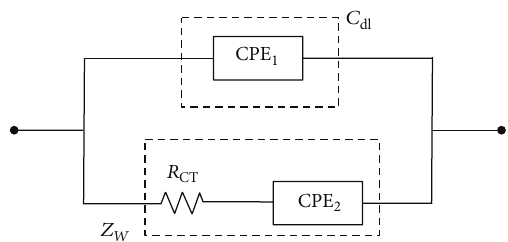
Figure 5: AC-equivalent circuit of the systems under analysis.